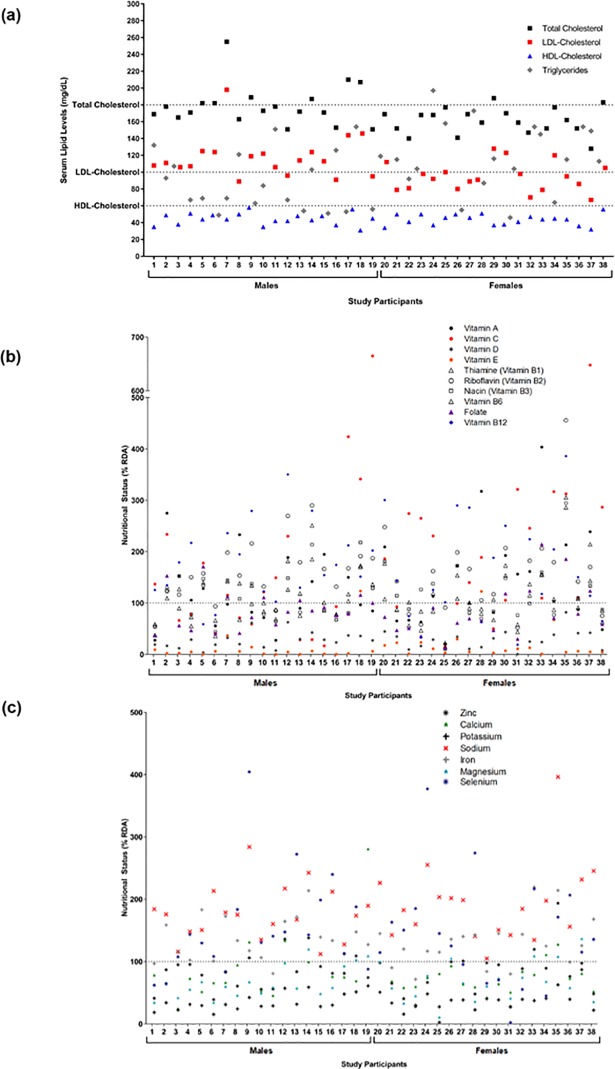
Serum lipid levels and micronutrient status.(a) Levels of total cholesterol, low-density lipoprotein (LDL)-cholesterol, high-density lipoprotein (HDL)-cholesterol, and triglycerides (TG) in all children. Dotted lines represent study inclusion criteria cut-offs for total, LDL-, or HDL-cholesterol. Levels of (b) vitamins or (c) minerals in all children relative to the Recommended Daily Intake (RDA) value for each nutrient. Values above the dotted line indicate that the RDA was met for the micronutrient, and values below the dotted line indicate that the RDA was not met for the micronutrient.